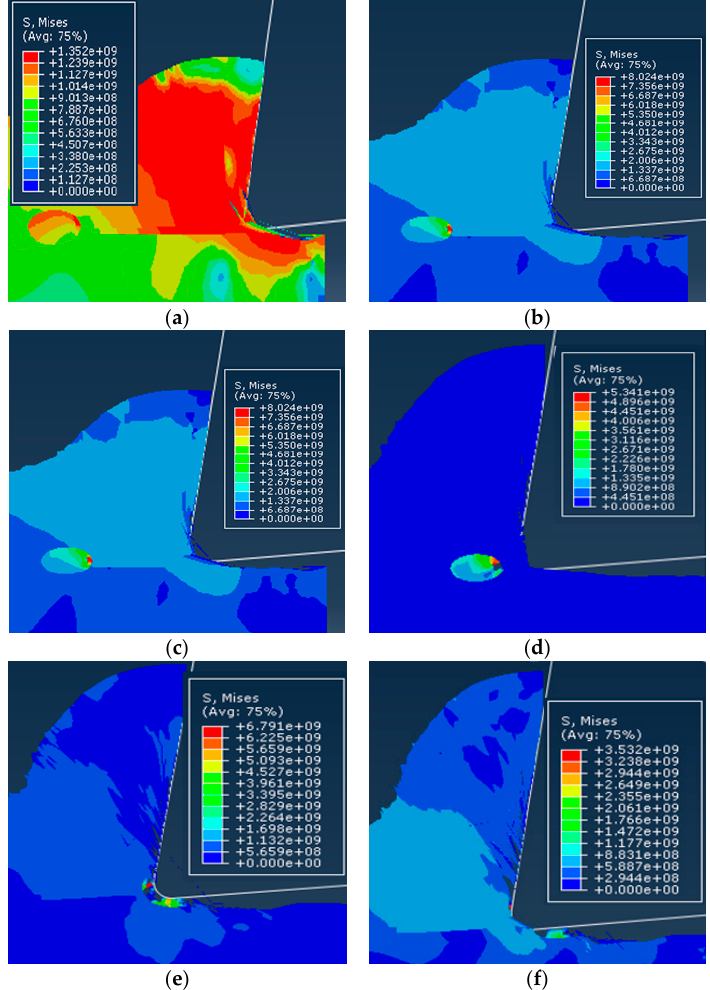
Figure 15. Simulation of the cutting process while the particles are positioned on the cutting path: ( a ) Stress concentration in the particle, ( b ) movement of the particle in position, ( c ) breakdown of particle, ( d ) particle is cut off, ( e ) particle removal is completed, ( f ) part of the particle is left on the cutting surface.